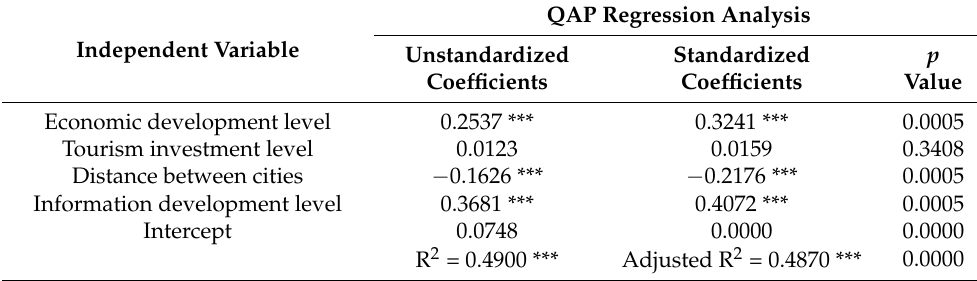
QAP Regression Analysis Unstandardized Standardized Coefficients Coefficients